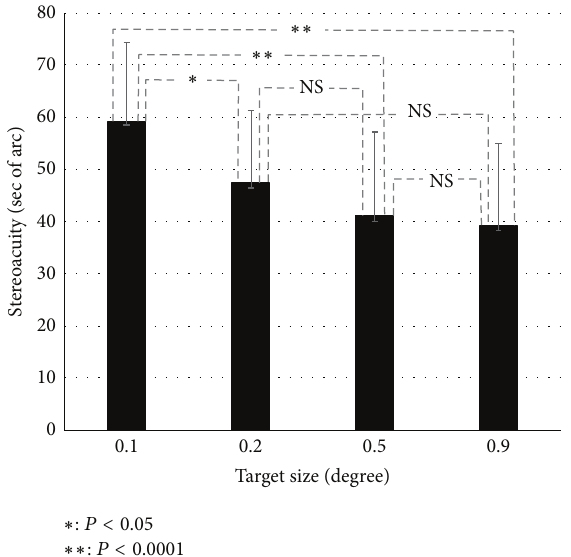
Figure 2: Average stereoacuity values for each target size. From the left of the graph, target sizes of 0.1 ∘ , 0.2 ∘ , 0.5 ∘ , and 0.9 ∘ are shown.